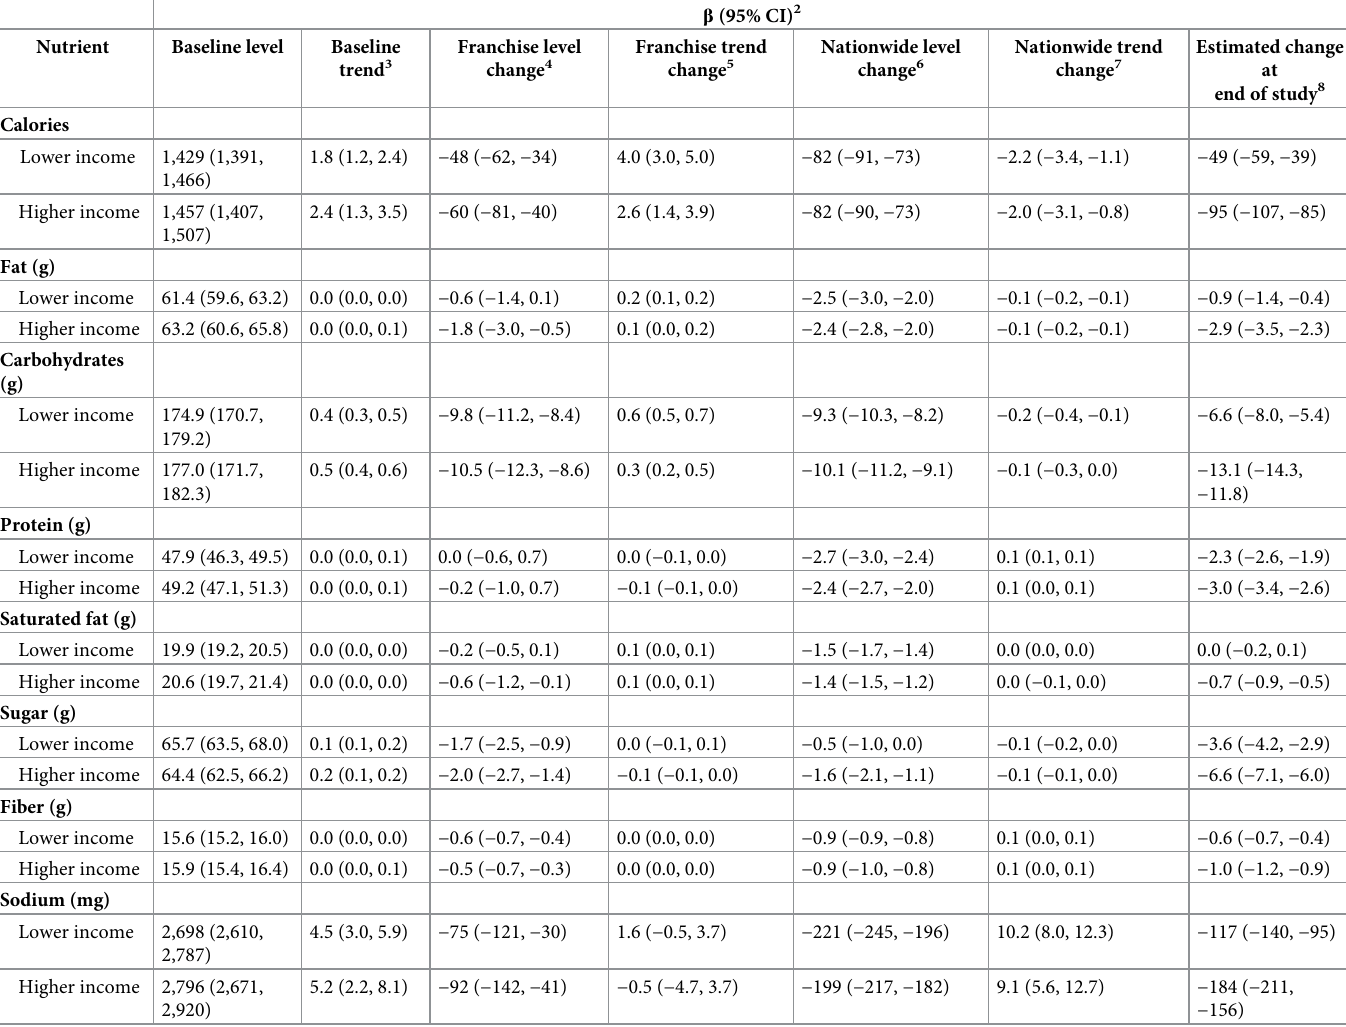
Table 3. Interrupted time series for change in mean calories and nutrients purchased per transaction after restaurant calorie labeling implementation (April 2017) and after nationwide calorie labeling implementation (May 2018) by median income of restaurant census tracts 1